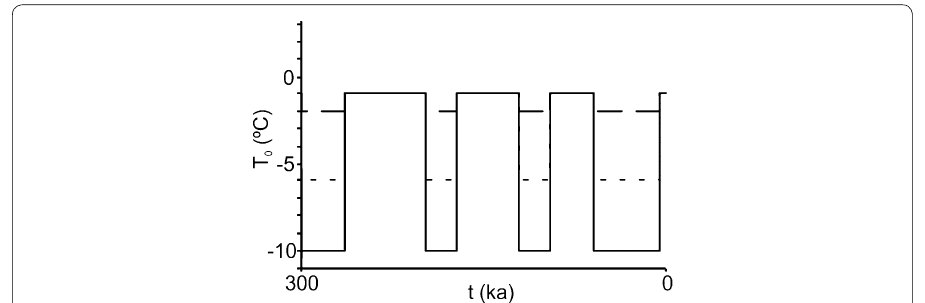
Fig. 4 Timeline of Pleistocene and Holocene climate events and temperature step. Solid line—temperature during glacial episode assumed as 10 °C colder than today; pointed line—temperature during glacial episode assume 5 °C colder than today; dashed line—temperature during glacial episode 1 °C colder than